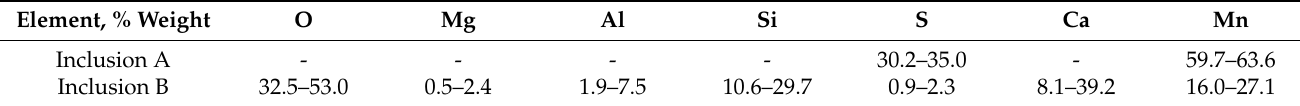
Figure 3. SEM observations of inclusions ( a ) on the cross and ( b ) longitudinal sections of CG sample and ( c ) EDS spectra examples of type A and B inclusions. Table 4. Average chemical composition of inclusions types A and B .